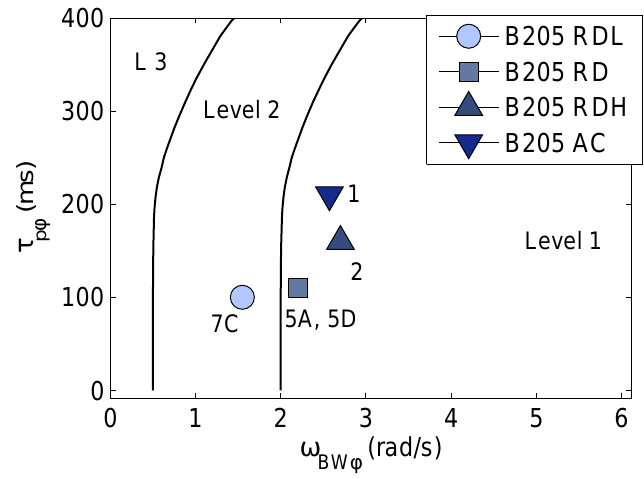
Figure 13. APC ratings obtained from the Pirouette MTE w.r.t. roll